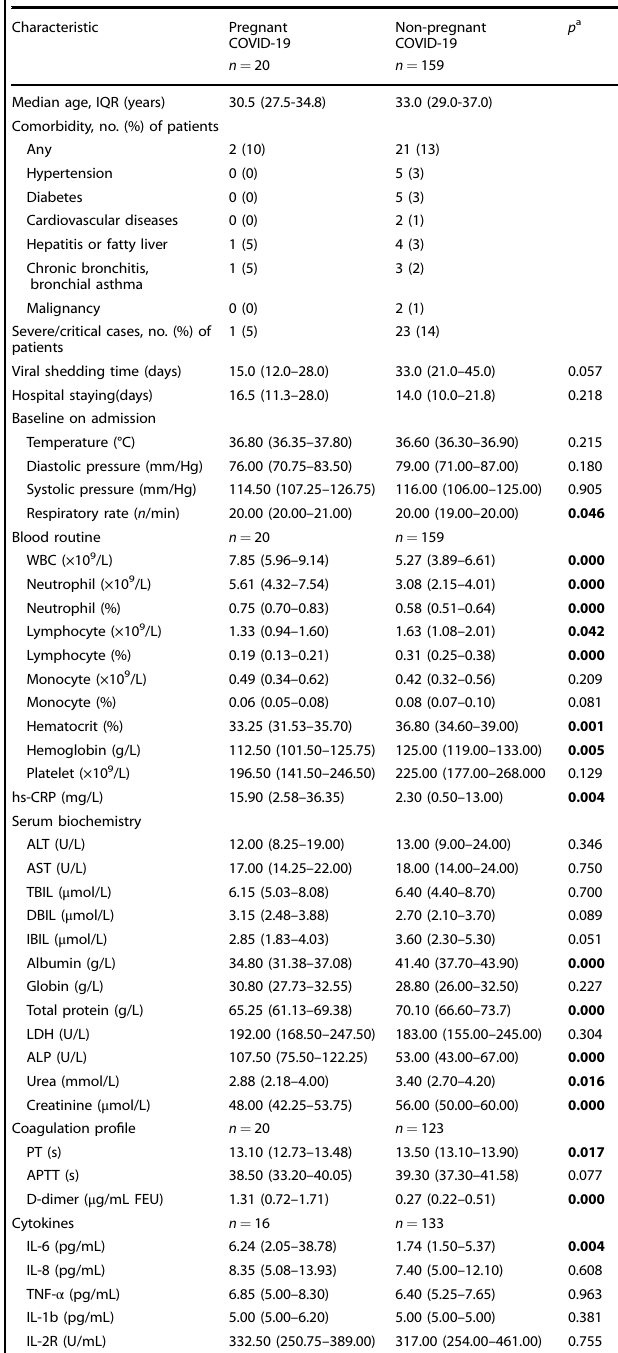
Table 1. Clinical characteristics of COVID-19 patients and laboratory tests